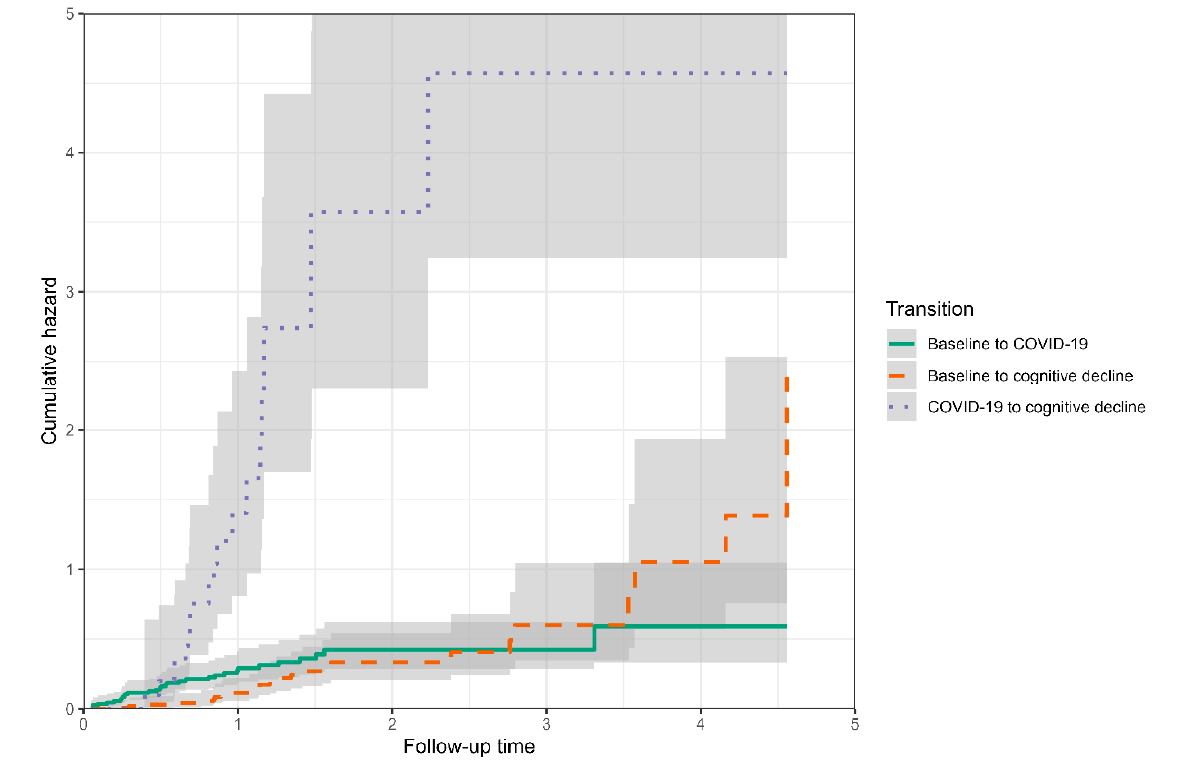
Figure 3. Graph of cumulative hazards of developing a cognitive decline over time in a 3-state model: from baseline to COVID-19 (green continuous line), from baseline to cognitive decline (pink dashed line), and from COVID-19 to cognitive decline (purple dotted line). Gray bands represent the 95% confidence interval.